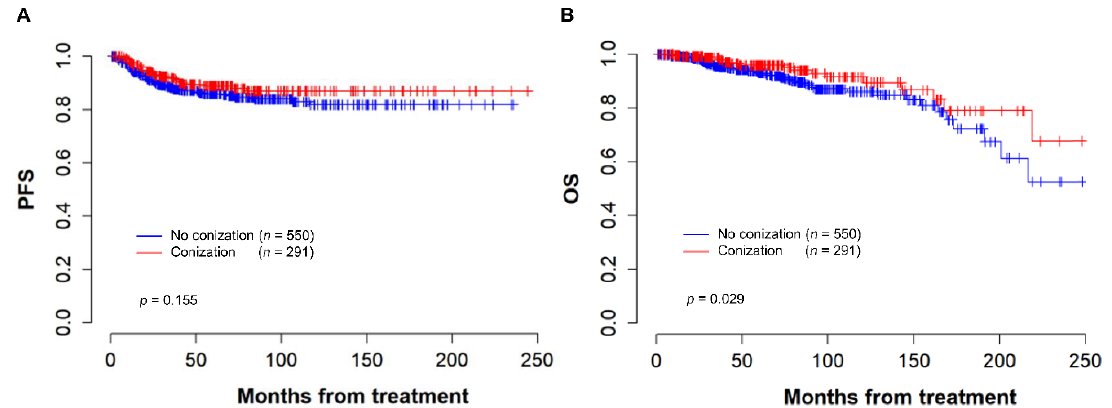
Figure 1. Kaplan–Meier curves for ( A ) progression free survival and ( B ) overall survival based on conization performed before radical hysterectomy.